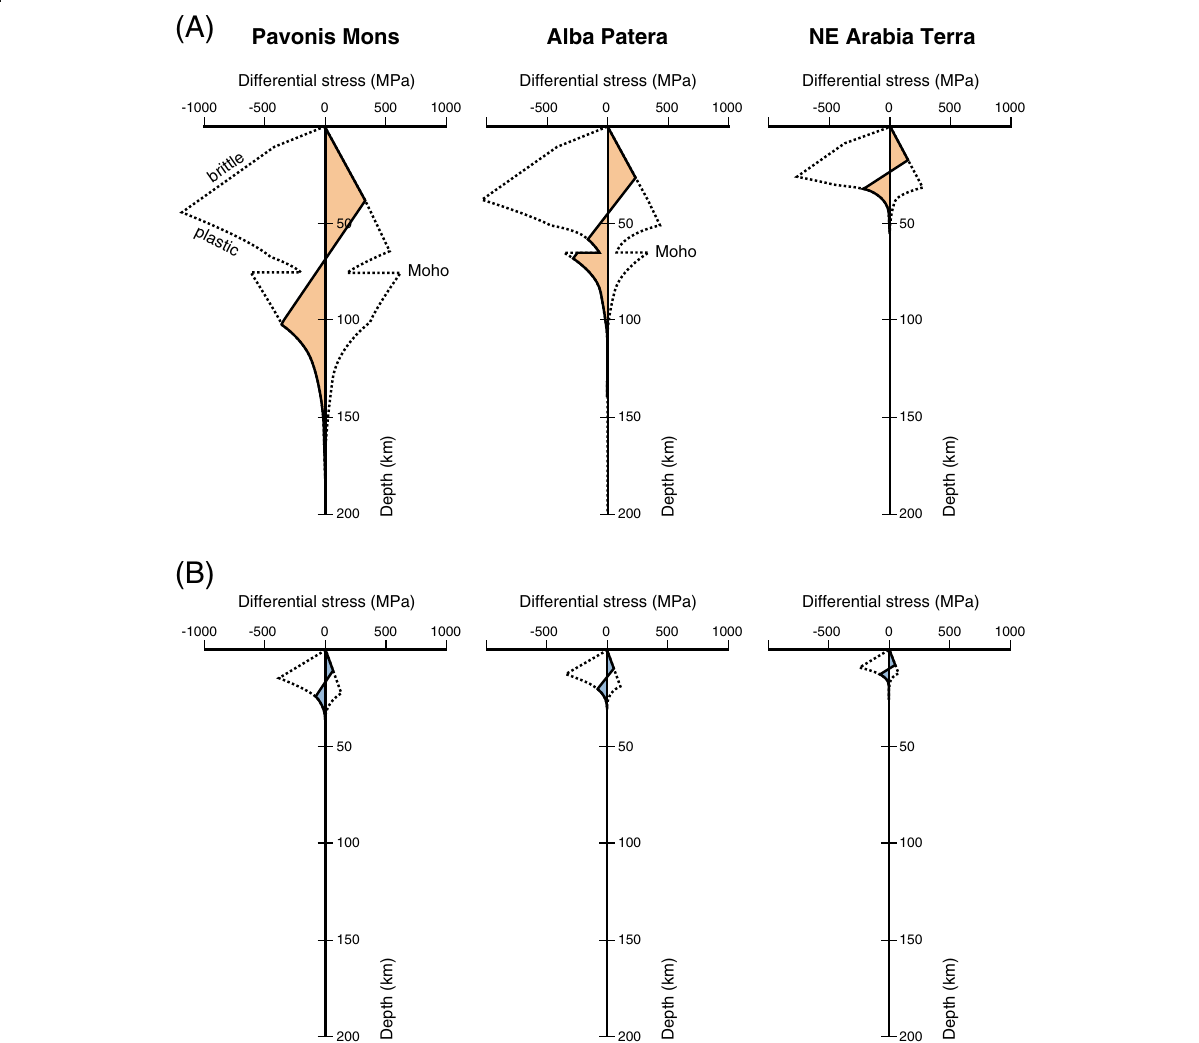
Fig. 6 Rheological structures of the Martian lithosphere at Pavonis Mons, Alba Patera, and NE Arabia Terra calculated under dry ( a ) and wet ( b ) conditions. The plastic strength changes across the crust-mantle boundary (Moho) due to a change in flow laws. Elastic thickness was calculated from the integrated bending moment within the lithosphere (see text for